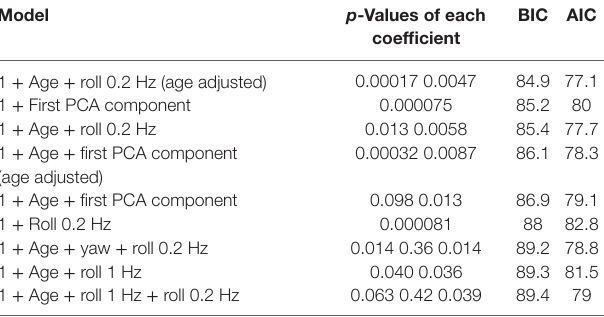
TaBle a1 | Comparison of logistic regression models.